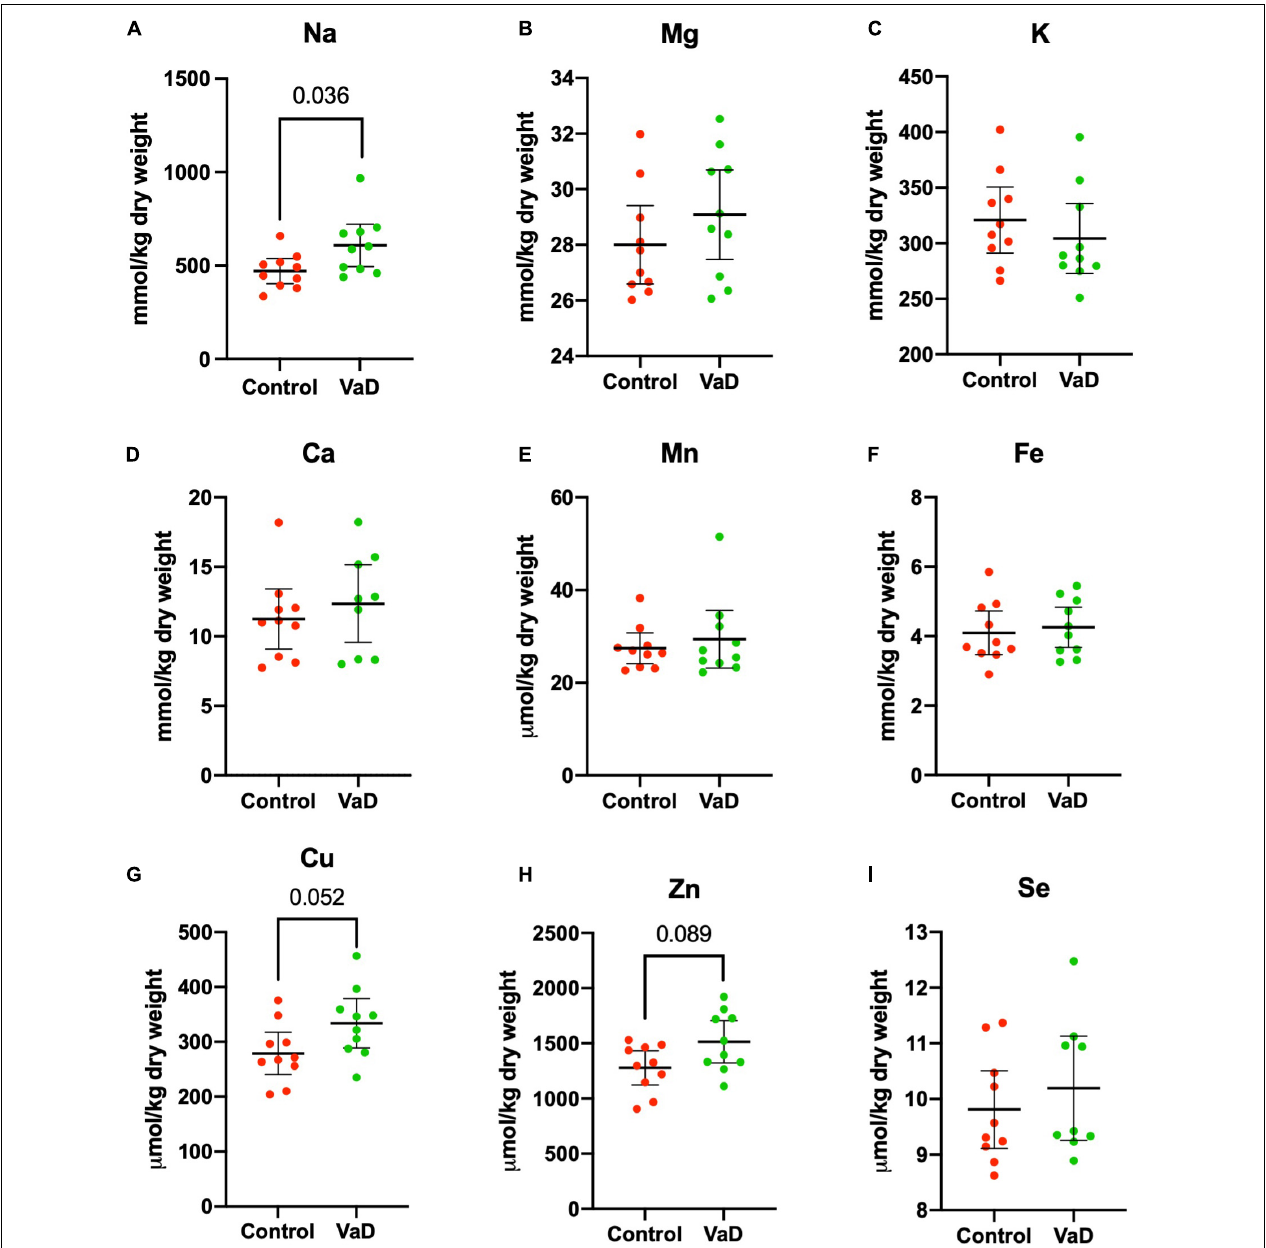
FIGURE 2 | Dry-weight concentrations of nine essential elements (A–I) in the hippocampus compared between control (red) and VaD (green) post-mortem human tissue. Data shown represent elemental means ± 95% CI from control ( n = 10) and VaD ( n = 10). A single outlier from each of Ca and Se datasets was removed from the plot for clarity. n = number of post-mortem human